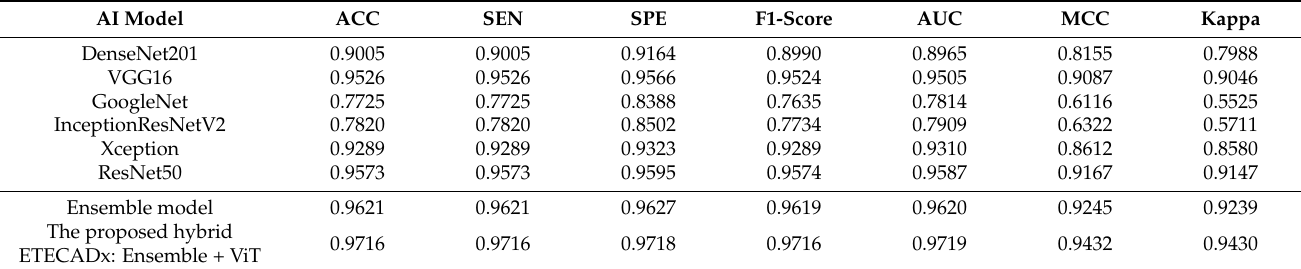
Table 10. Validation classification results for the binary approach using all AI models including the ensemble learning and the proposed ETECADx framework. The real unseen dataset (Dataset2-B) is used for this study.